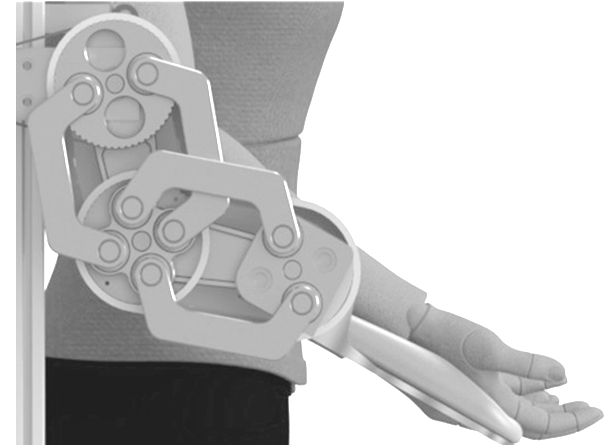
Figure 1. CAD concept of gravity compensation and torque assis- tance mechanism used as an elbow support